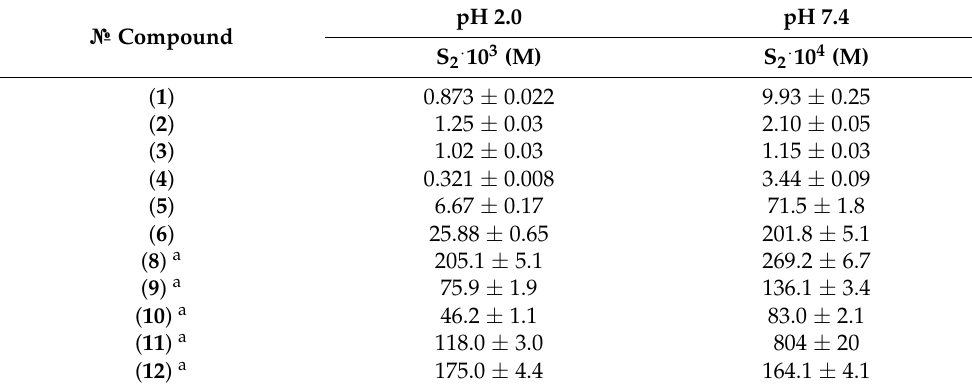
Figure 8. Solubility of the considered compounds in buffer solutions pH 2.0 ( a ) and pH 7.4 ( b ) at 298.15 K (compounds numbering corresponds to Figures 2 and 7). Table 1. Solubility of the compounds in buffer solutions pH 2.0 and pH 7.4 at 298.15